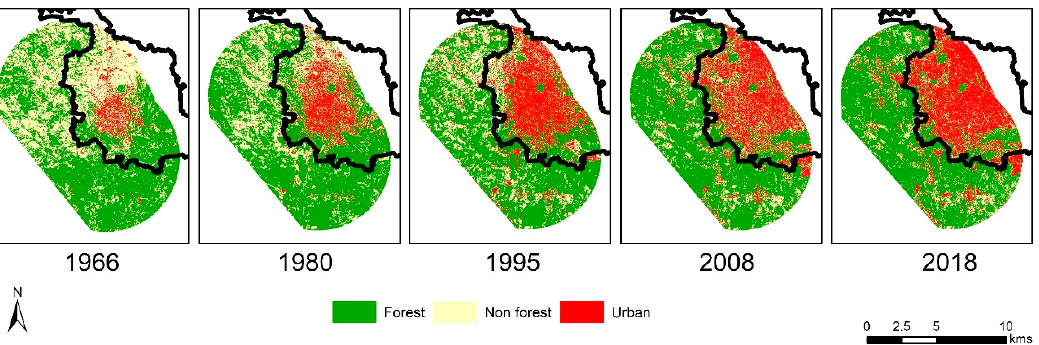
Figure 2. Land use and land cover maps from 1966 to 2018 in peri ‐ urban and urban Xalapa city . Table 2. Annual deforestation rates (%) and area covered by forest (ha) from 1966 to 2011. The area of forest cover for the initial (A1) and final (A2) years during each transition period are as follows. Period